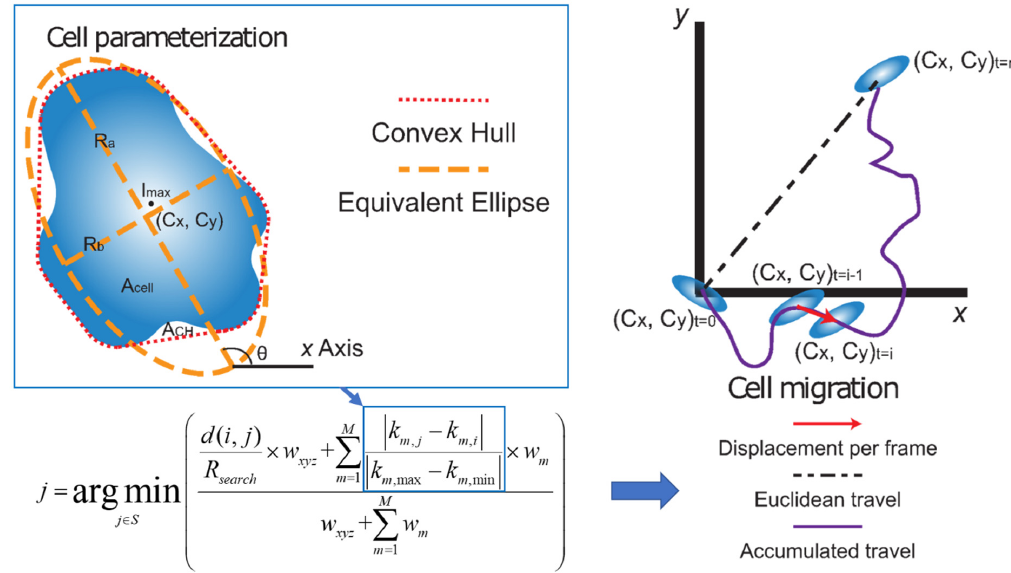
Figure 7. Cell parameterization and tracking representation where extracted cell parameters ( k 1,2,3, ∙∙∙ , M ), together with spatial information ( x , y , z ) and associated weights ( w xyz and w m ), are used to find the most probable matching cells between image frames i and j . The pairing cell j is chosen as the one with the minimum weighted deviation of parameters from cell i in the first image.